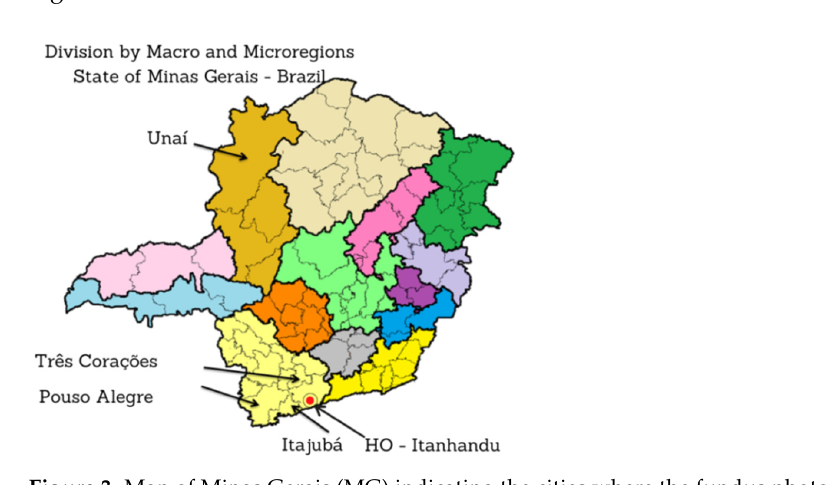
Figure 3. Map of Minas Gerais (MG) indicating the cities where the fundus photographs were taken and the region where Hospital de Olhos (HO) is located.